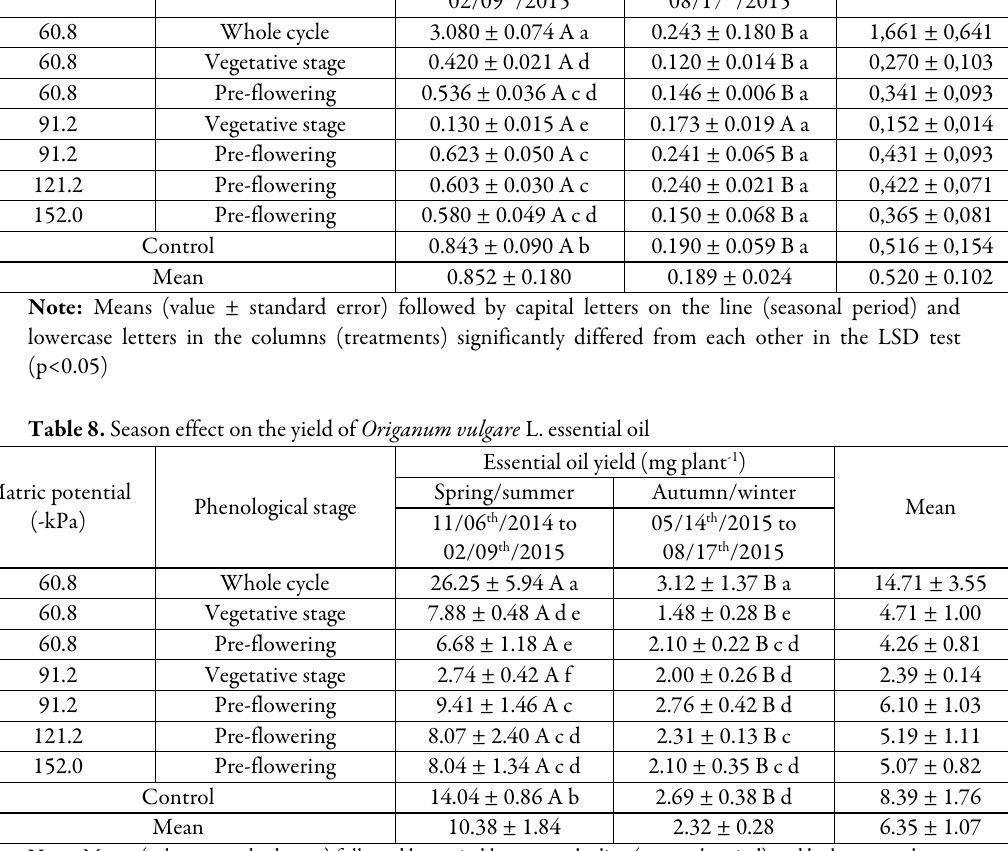
Table 7. Season effects on the content of Origanum vulgare L. essential oil Matric potential